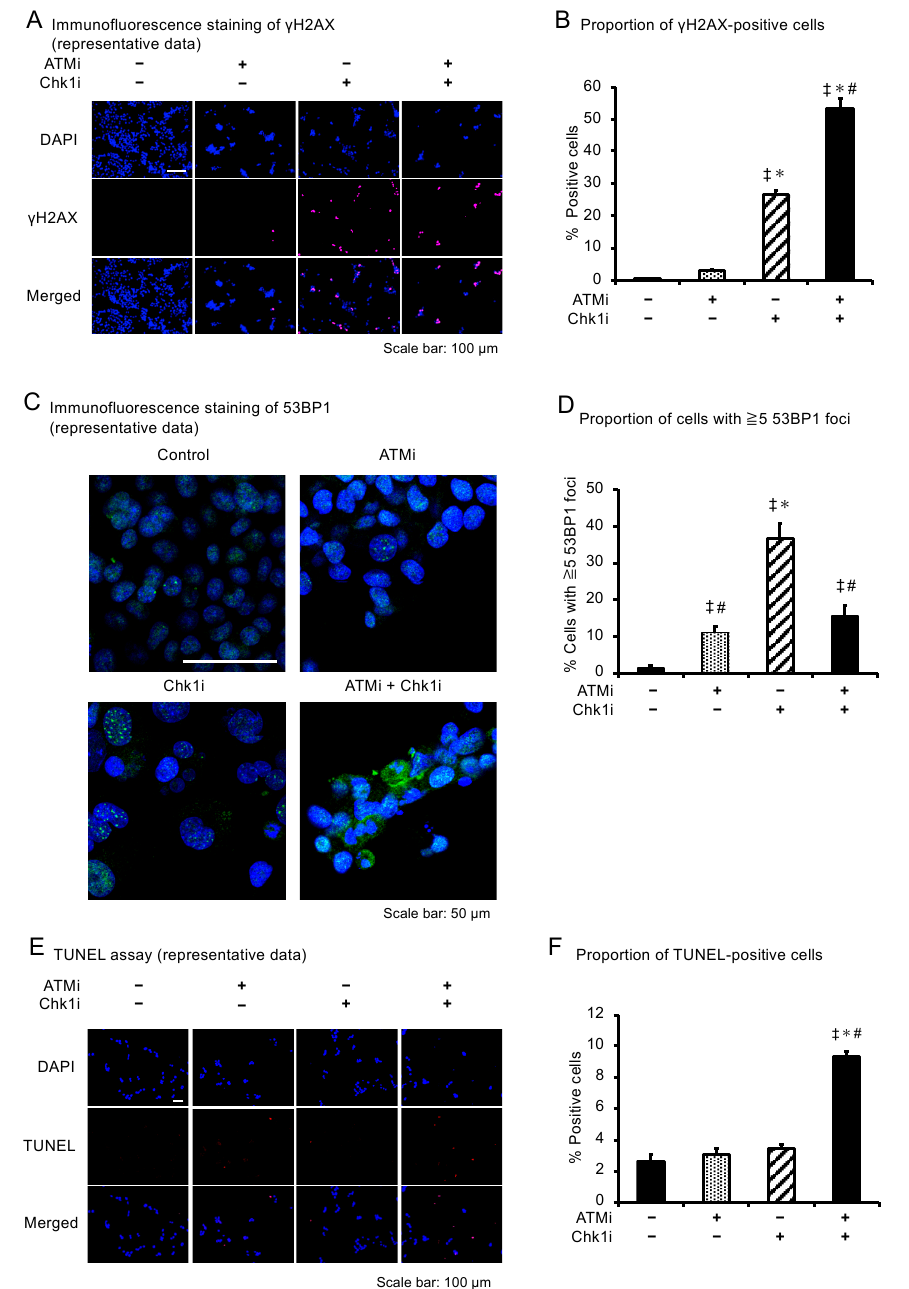
Figure 4. DNA damage and apoptosis of cancer cells under the combined ATMi and Chk1i treatment. ( A ) Immunofluorescence staining of γ H2AX (pink) in HCT116 cells treated with ATMi (10 μ M), Chk1i (0.03 μ M), or both drugs for 48 h. DAPI = blue. Scale bars = 100 μ m. ( B ) Ratio (%) of γ H2AX-positive HCT116 cells. Data are presented as mean ± SE ( n = 6; 6 fields/well; ‡ p < 0.05, vs. control; * p < 0.05, vs. ATMi group, # p < 0.05, vs. Chk1i group). ( C ) Immunofluorescence staining of 53BP1 (green) in HCT116 cells treated with ATMi (10 μ M), Chk1i (0.03 μ M), or both drugs for 48 h. DAPI = blue. Scale bars = 50 μ m. ( D ) Ratio (%) of HCT116 cells with ≥ 5 53BP1 foci. Data are presented as mean ± SE ( n = 3; 30 cells/well; ‡ p < 0.05, vs. control; * p < 0.05, vs. ATMi group, # p < 0.05, vs. Chk1i group). ( E ) TdT-mediated dUTP nick-end labeling (TUNEL) analysis of HCT116 cells treated with ATMi (10 μ M), Chk1i (0.03 μ M), or both drugs for 24 h. TUNEL = red; DAPI = blue. Scale bars = 50 µ m. ( F ) Ratio (%) of TUNEL-positive HCT116 cells. Data are presented as mean ± SE ( n = 6; 6 fields/well; ‡ p < 0.05, vs. control; * p < 0.05, vs. ATMi group, # p < 0.05, vs. Chk1i